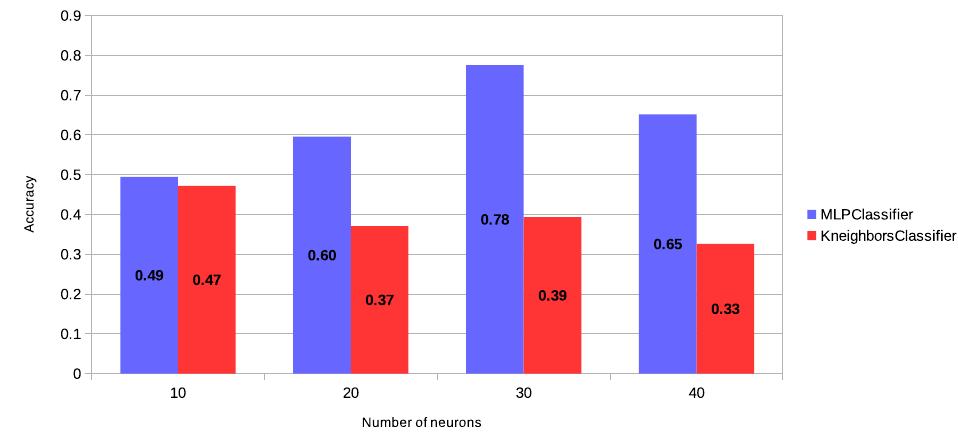
Figure 9. Classification model for primal method—testing different classification algorithms (1 hidden layer, tanh activation function, lbfgs